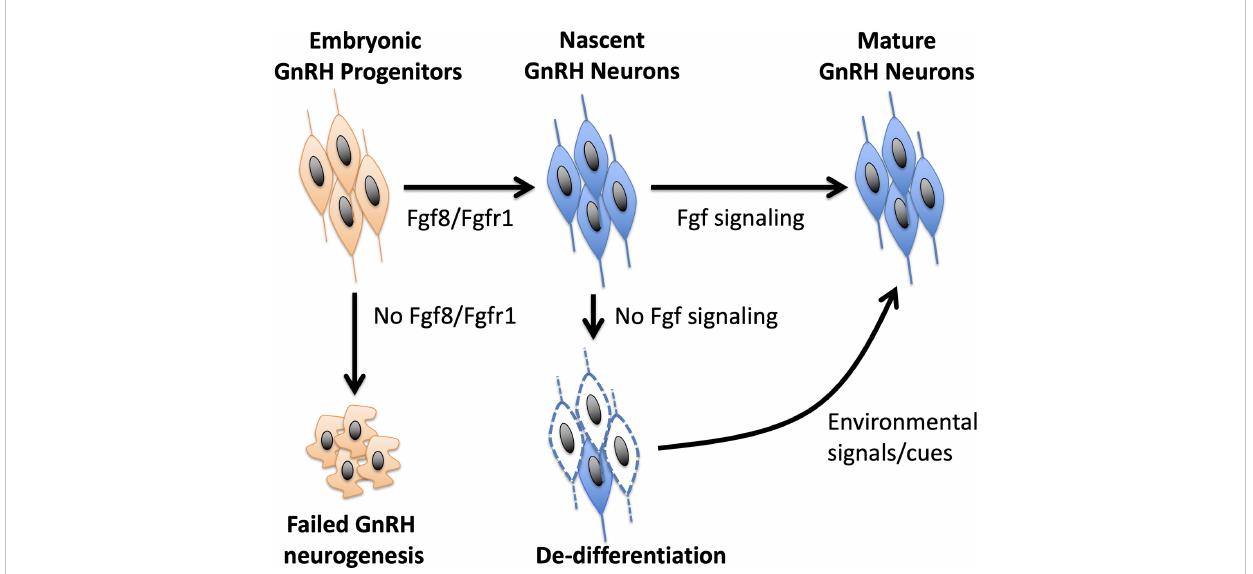
FIGURE 1 A model of how Fgf signaling controls the neurogenesis and differentiation of GnRH neurons. Fgf8 signaling through Fgfr1 is critical for GnRH neurogenesis from GnRH progenitors. Once nascent GnRH neurons are formed, continued exposure to Fgf signaling is required to maintain their differentiated state. In the absence of Fgf signaling, GnRH neurons fail to express GnRH and become de-differentiated. However, this de-differentiated state can be reversed by positive environmental signals, such as OS housing, that may upregulate neuroprotective molecules in the